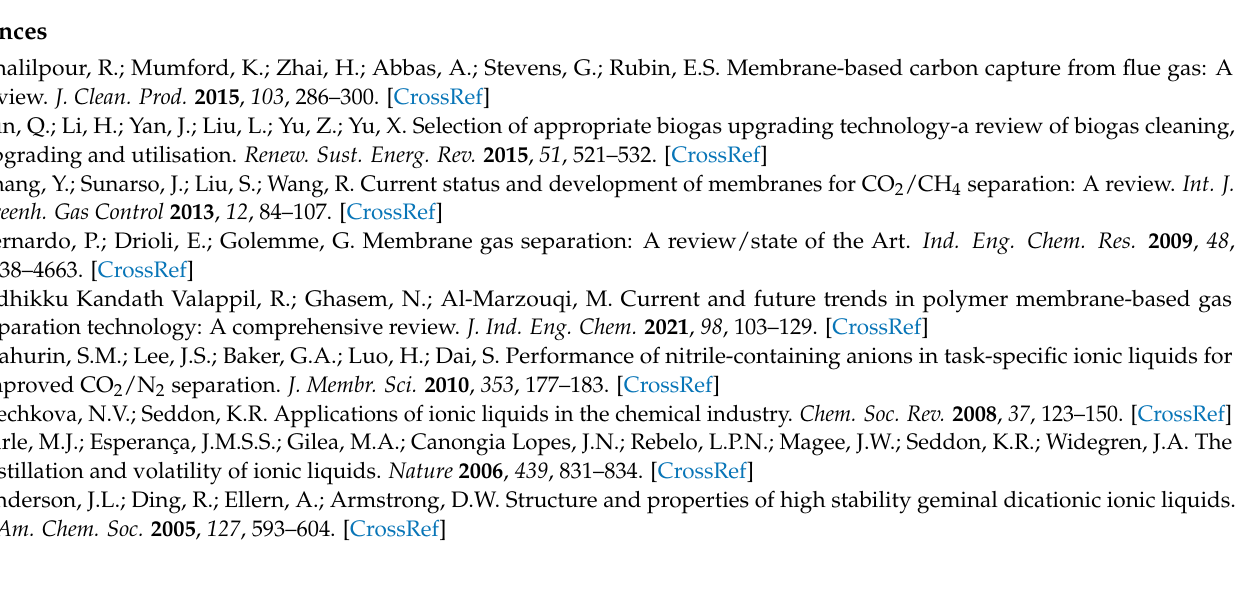
Figure S3: 1 H NMR spectrum for [C 6 BrmIm]Br; Figure S4: 1 H NMR spectrum for [C 10 BrmIm]Br; Figure S5: 1 H NMR spectrum for [((C 2 O) 3 C 2 I)ImIm]I; Figure S6: 1 H NMR spectrum for [NBM-Br]; Figure S7: 1 H NMR spectrum for [NBM-Im]; Figure S8: 1 H NMR spectrum for [NBM-ImC 4 Br]Br; Figure S9: Structures for six norbornenyl-containing imidazolium-based mono- and di-cationic ILs studied in this work; Figure S10: 13 C NMR spectrum for [NBM-ImC 4 mIm][Tf 2 N] 2 ; Figure S11: 13 C NMR spectrum for [NBM-ImC 13 C NMR spectrum for [NBM- 4 m(2-m)Im][Tf 2 N] 2 ; Figure S12: ImC 6 mIm][Tf 2 N] 2 ; Figure S13: 13 C NMR spectrum for [NBM-ImC 10 mIm][Tf 2 N] 2 ; Figure S14: 13 C NMR spectrum for [NBM-Im((C 2 OC 2 ) 2 O)mIm][Tf 2 N] 2 ; Figure S15: FT-IR spectrum for NBM- containing imidazolium-based ILs; Figure S16: 1 H NMR spectrum for p ([NBM-ImC 6 mIm][Tf 2 N] 2 ); Figure S17: 1 H NMR spectrum for p ([NBM-ImC 4 m(2-m)Im][Tf 2 N] 2 ); Table S1: Optimizing the reac- tion conditions for effective polymerization of [NBM-DILs][Tf 2 N] 2 ; Figure S18: 1 H NMR spectrum for BCP1-C 6 ; Figure S19: 1 H NMR spectrum for BCP2-C 6 ; Figure S20: FT-IR spectra for BCPs; Figure S21: Flexibility of membranes; Table S2: Pure gas diffusivity and solubility